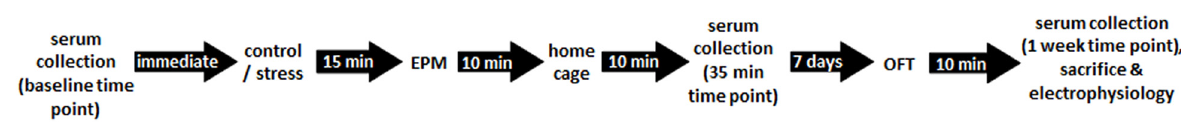
FIGURE 1 | Experimental timeline for all groups. Rats are bled from the lateral saphenous vein to collect serum for corticosterone quantification and are then immediately exposed to control or stress conditions for 15 min. Anxiety-like behavior is then immediately tested in the elevated plus maze for 10 min, and animals are then returned to home cages. Ten minutes later (35 min after the start or control conditions) blood is collected again from the lateral saphenous vein. Rats are then housed undisturbed for a week, at which point anxiety-like behavior is tested again in the open field test. At the conclusion of the test, blood is again collected from the lateral saphenous vein and animals are sacrificed for electrophysiological